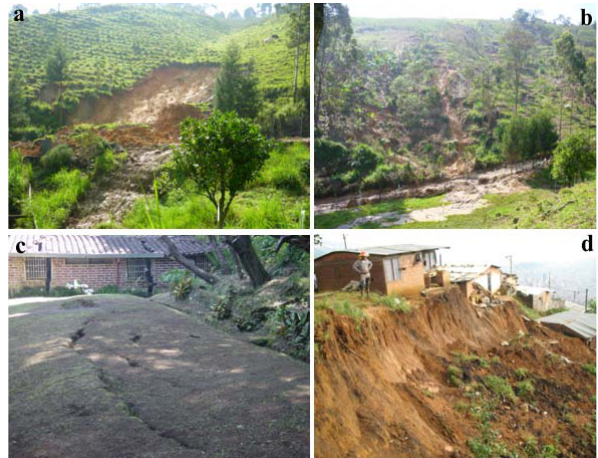
Fig. 2. Examples of the landslides recorded in the study area: (a) a rotational-translational slide in San Cristobal; (b) an earth flow in Pajarito; (c) a house affected by deep lateral spread in Robledo; and (d) a rotational slide in El Pesebre in November 2006, in which ten houses were destroyed and more than twenty five people affected (photos from